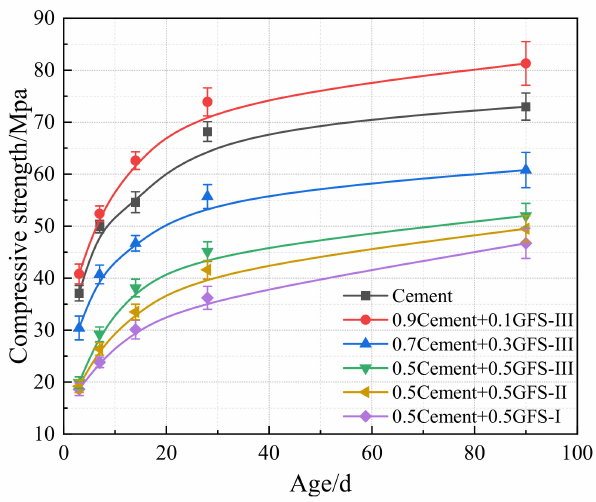
Figure 15. Compressive strength of hardened pastes of the blended cement at different